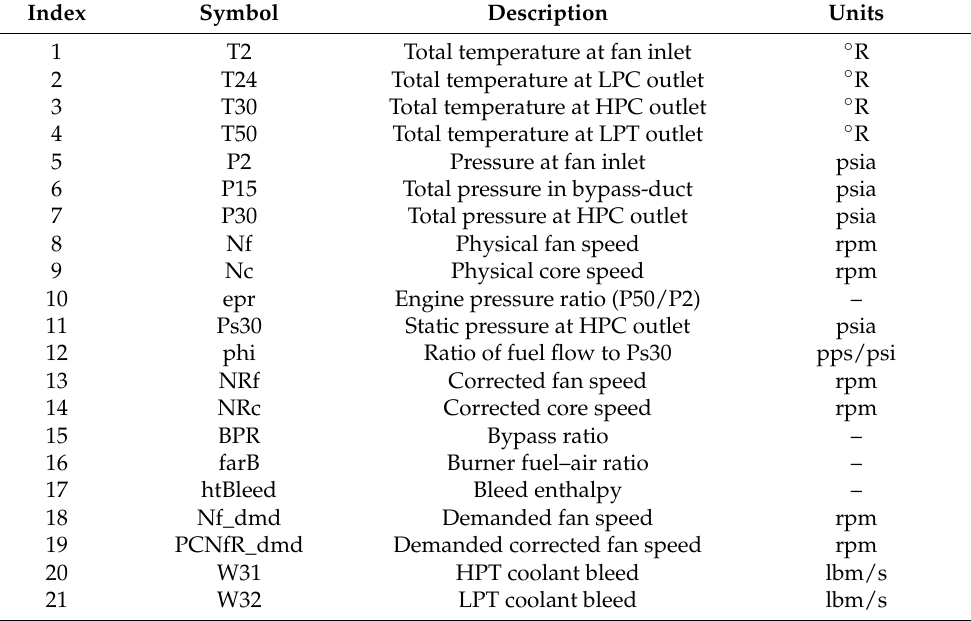
Table 2. Dataset sensor detailed